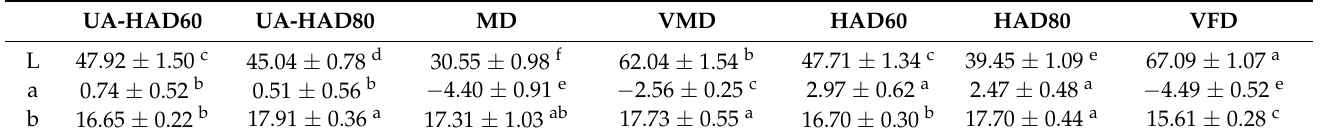
Table 1. The surface color of O. raphanipes subjected to different drying methods.